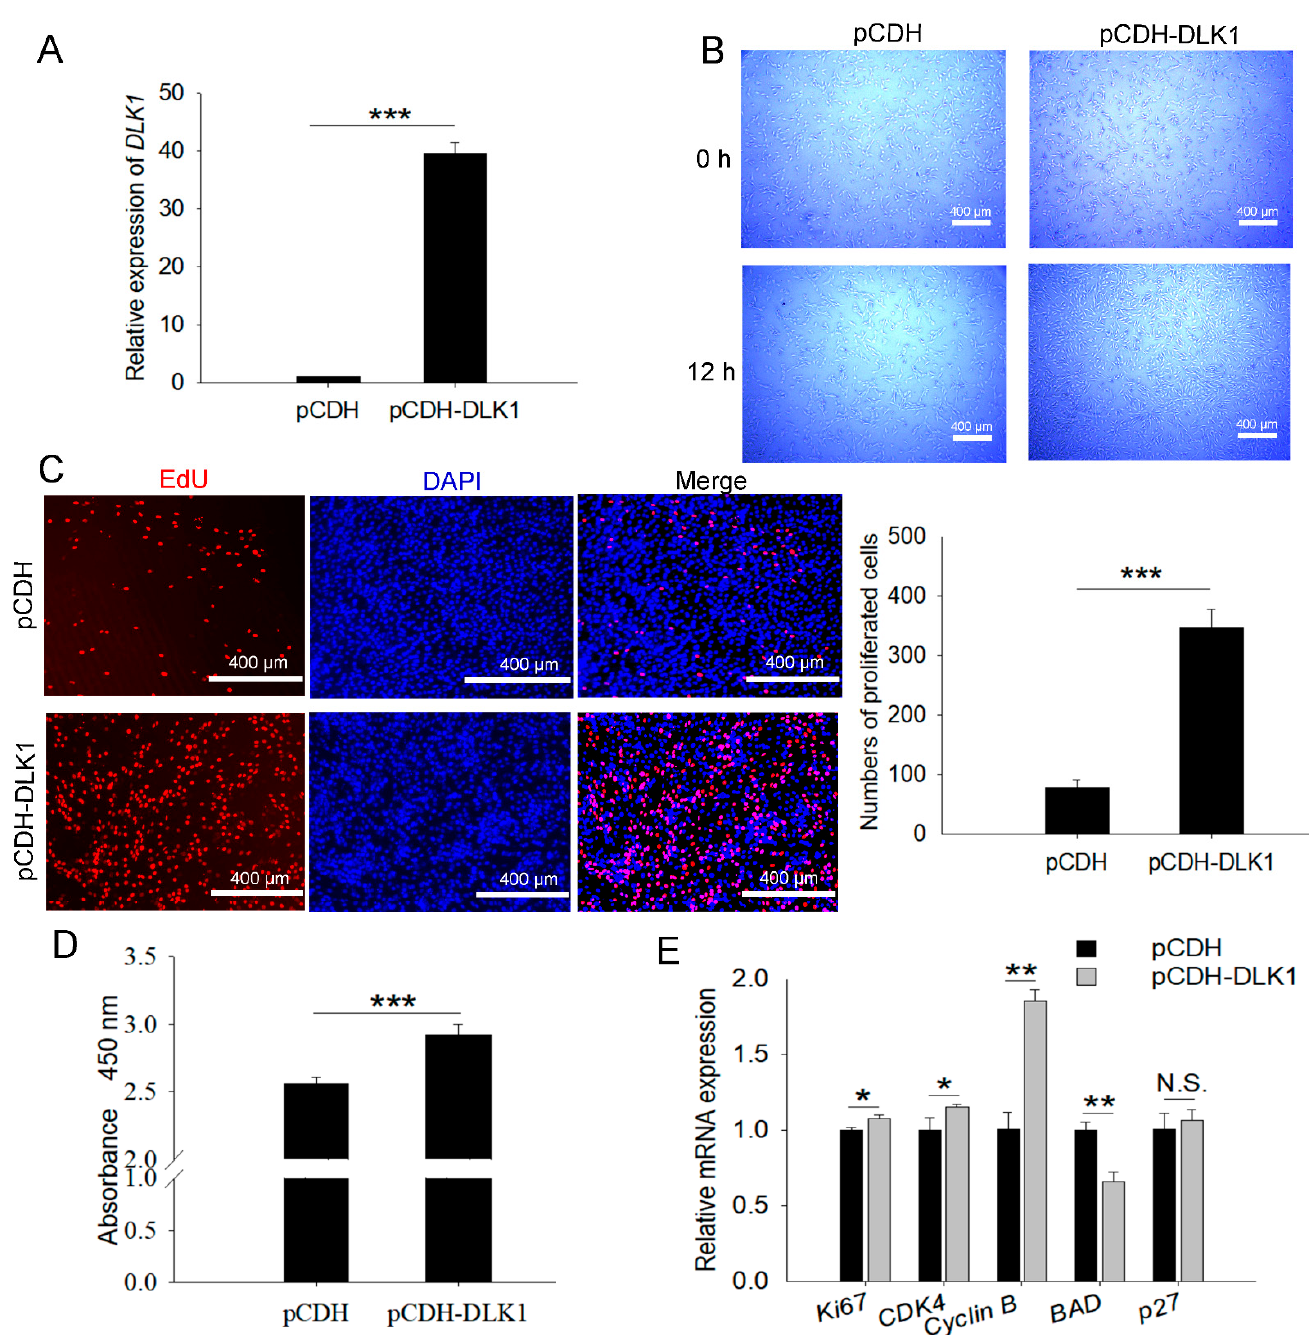
Figure 2. DLK1 promotes myoblast proliferation. ( A ) Efficiency of the detection of plasmid overexpression; ( B ) microscopic view of cell proliferation; scale bar = 400 µ m; ( C ) EdU staining for proliferated cells following pCDH- DLK1 transfection. Nuclei are stained with DAPI; red indicates EdU-positive proliferating cells. Representative images are shown in the left panel, and the statis- tical graphs in the right panel indicate the proliferating cells 48 h after transfection; n = 3 in each group; scale bar = 400 µ m; ( D ) CCK8 assay of proliferated myoblasts transfected with overexpression fragments; ( E ) the mRNA expression levels of proliferation marker genes. The data represent the mean ± SD of three independent experiments. GAPDH was used as a reference gene. * p < 0.05, ** p < 0.01, *** p < 0.001, N.S. represents not